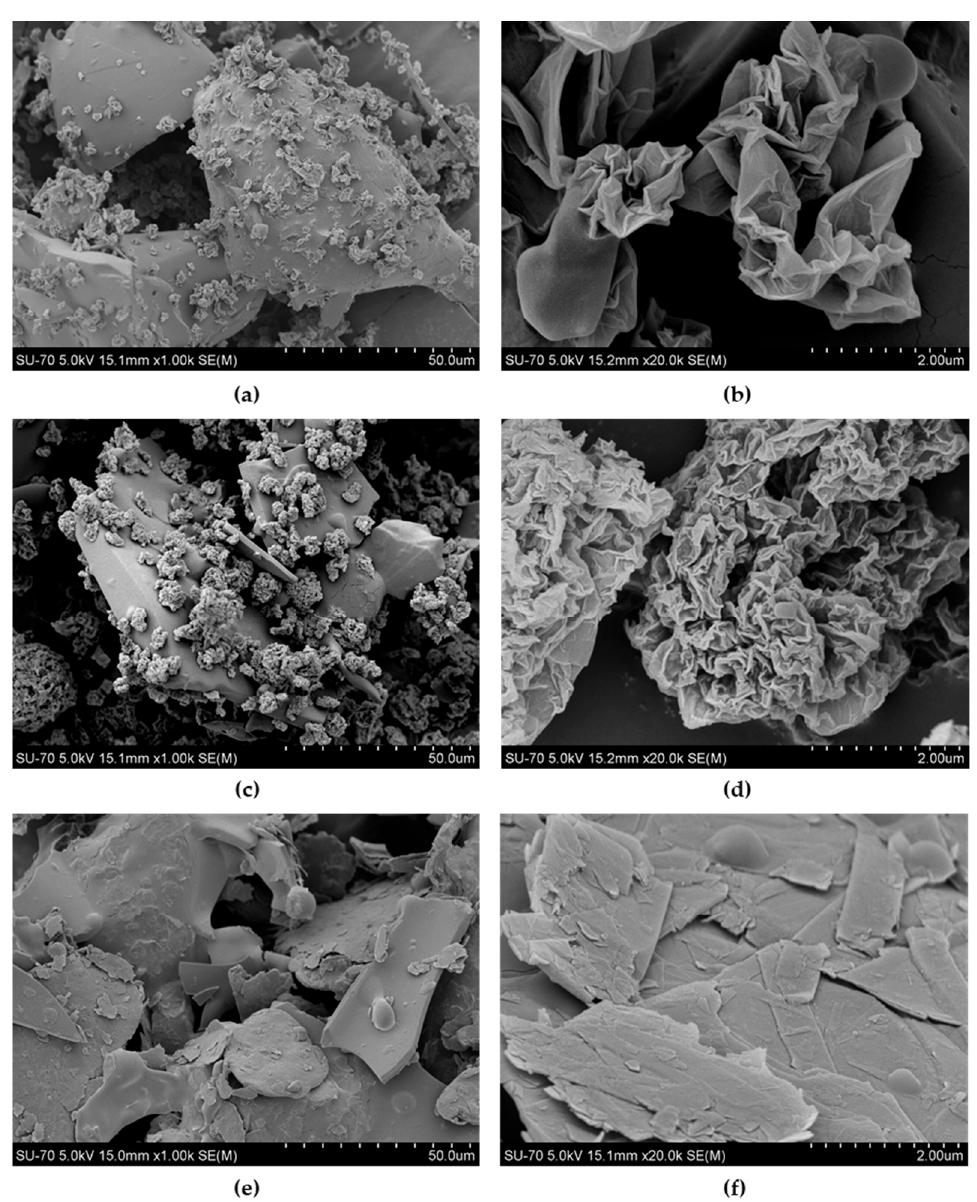
Figure 10. SEM images of the LS mixture with 1% w / w of GO ( a ) and ( b ), rGO ( c ) and ( d ), and Gr ( e ) and ( f ).